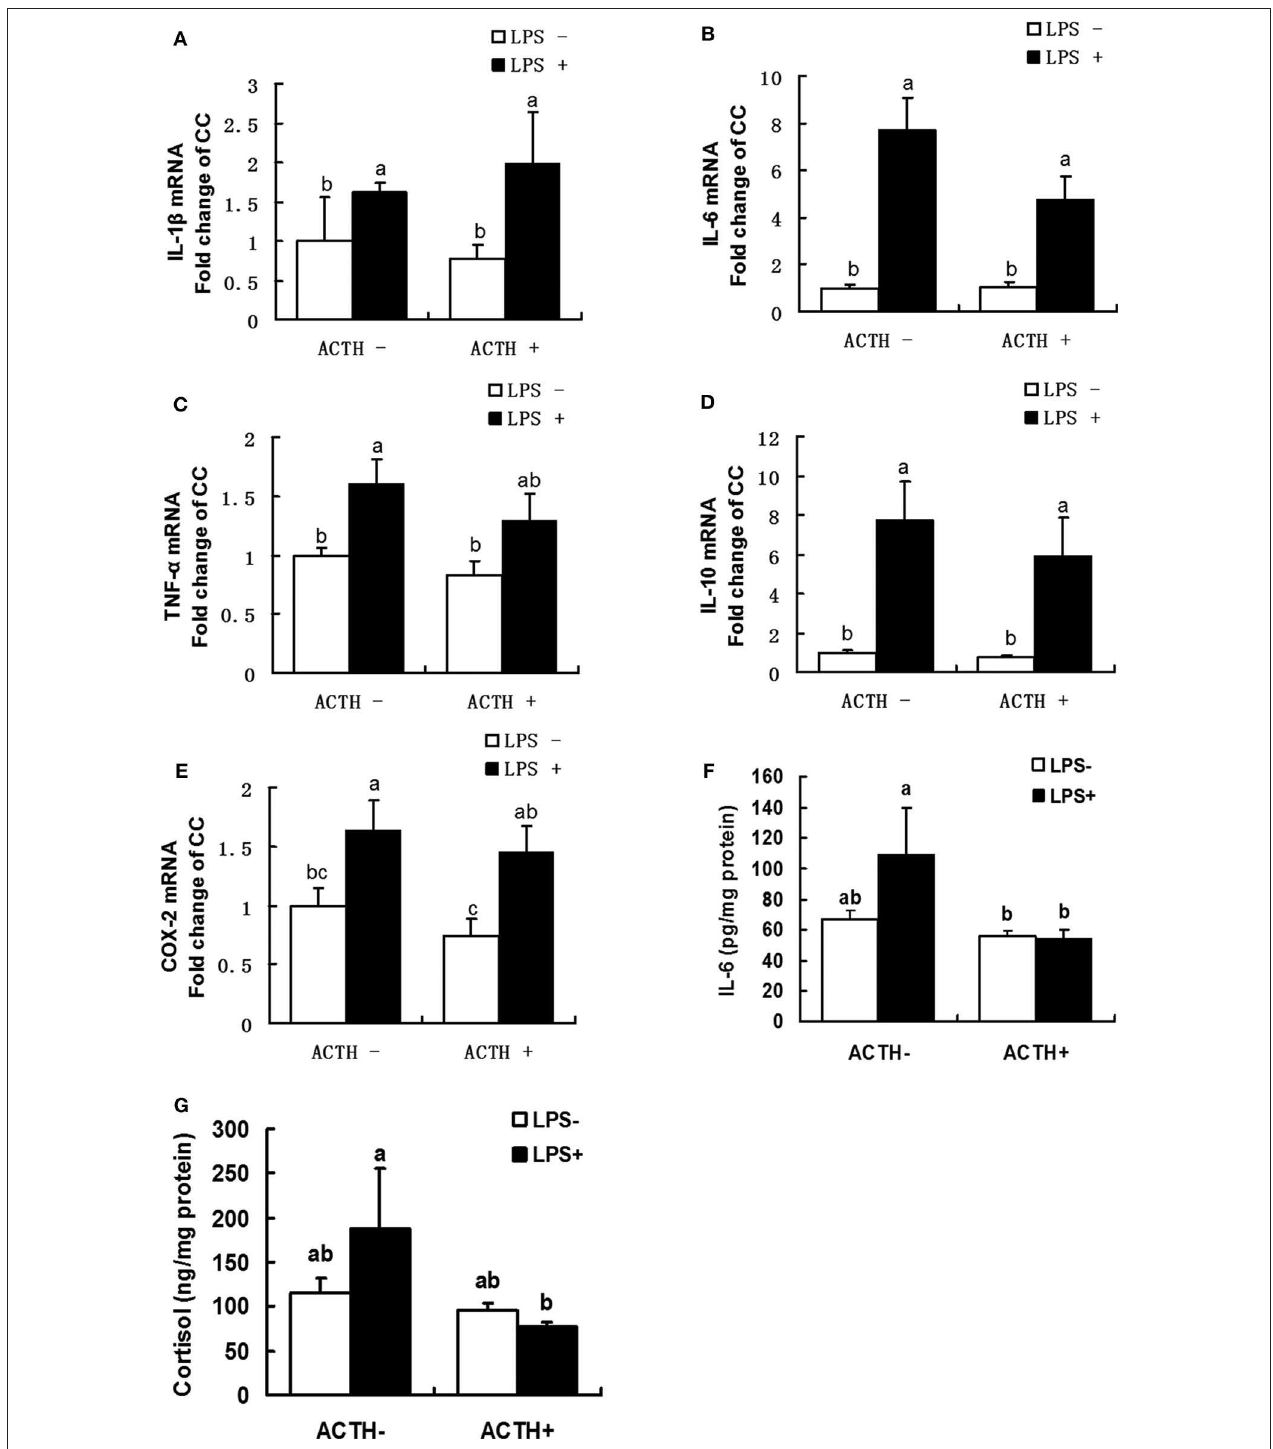
FIGURE 2 | Effects of lipopolysaccharide/ACTH on expressions of IL-1 β (A) , IL-6 (B) , TNF- α (C) , IL-10 (D) , and COX-2 (E) mRNAs, IL-6 protein (F) , and cortisol (G) secretion levels in local porcine adrenal gland tissue. Means with different letters (a, b, c, d, e, f) are significantly different ( P < 0.05) from each other, n = 5–6. Different superscript letters indicate significant differences between the same column. Data are expressed as mean ± SEM .